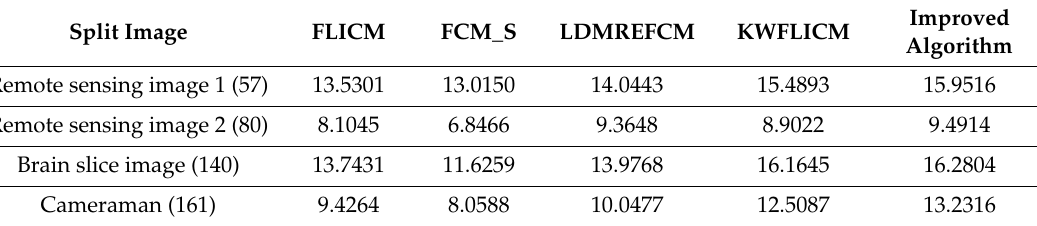
Table 1. Comparison of the peak signal-to-noise ratio (PSNR) (dB) for the anti-noise and Gaussian noise after using each algorithm.